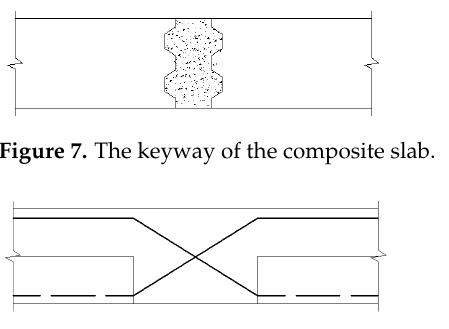
Figure 8. 45 − degree bending angle seam of traditional composite slab.